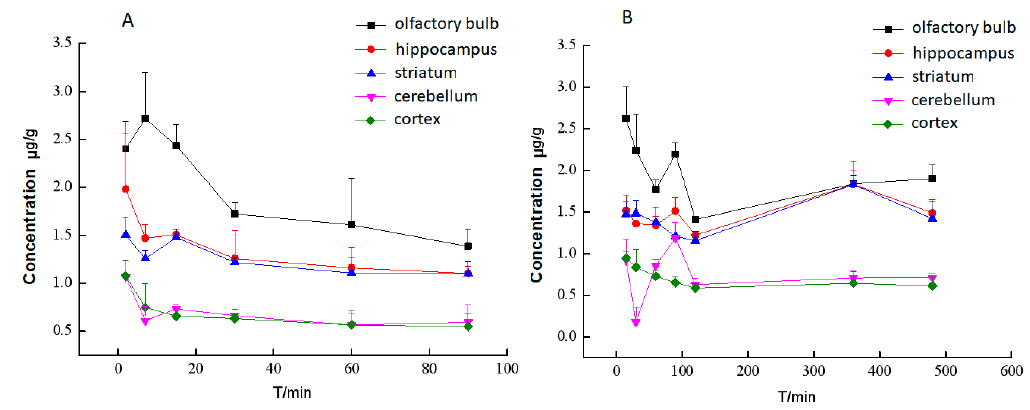
Figure 7. The concentrations (mean (SD)) of BA in different brain tissues after intravenous administration with BA ( A ) or BA-LP ( B ) on the MCAO model ( n = 5).